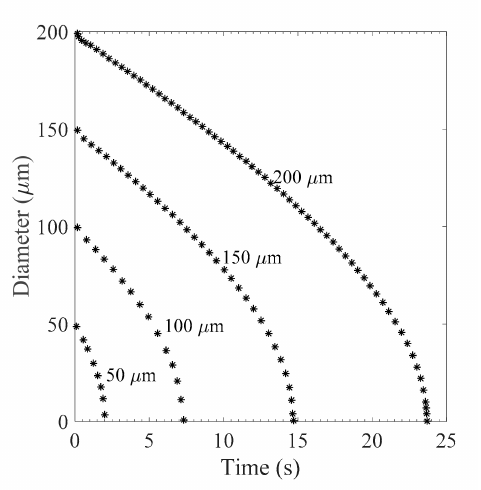
Figure 6. The Droplet Diameter Reduction as a function of time [37].